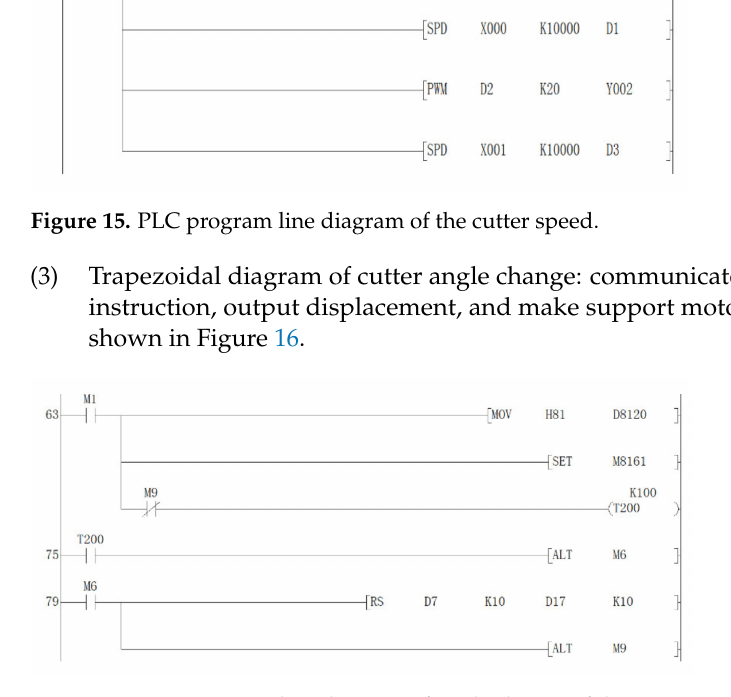
Figure 16. PLC program line diagram of angle change of the cutter.